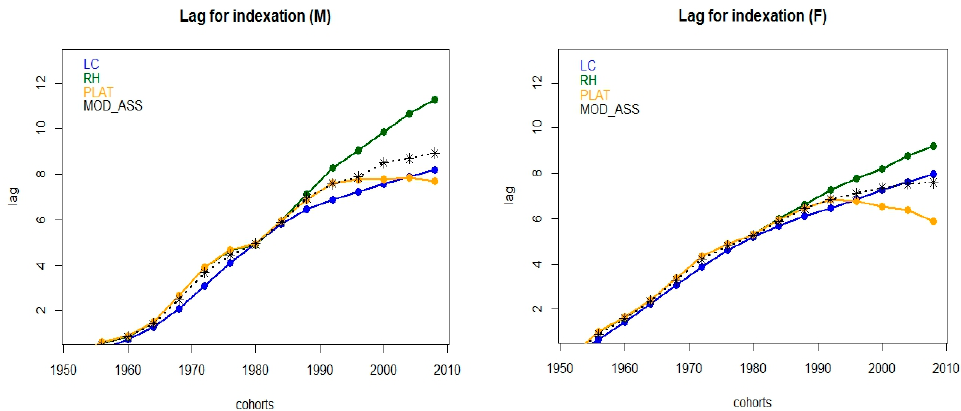
Figure 4. Lag for Figure 4. Lag for indexation.